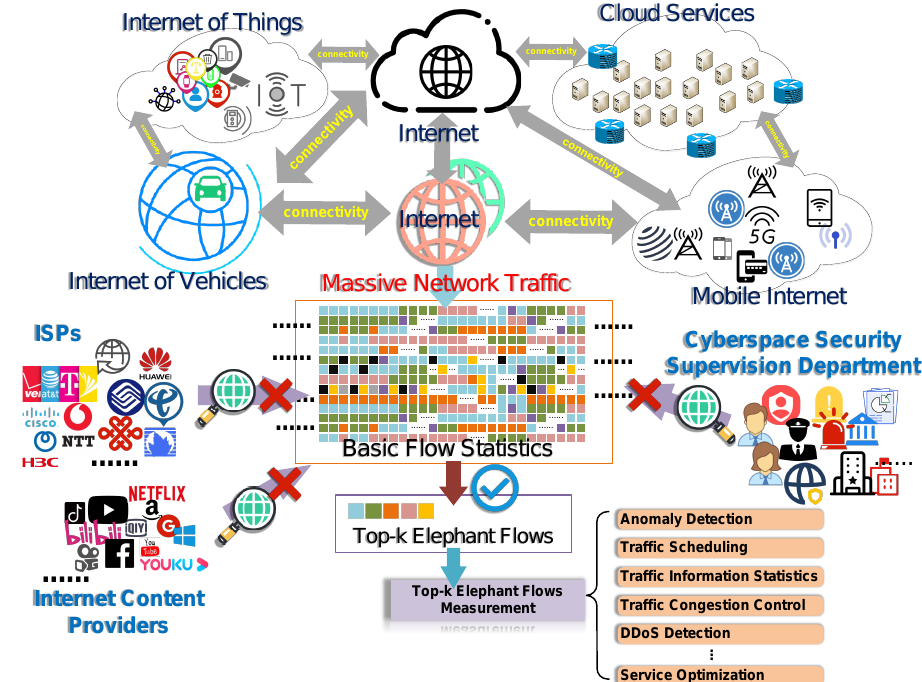
Figure 1. The significance of top- k flows measurement in networks.